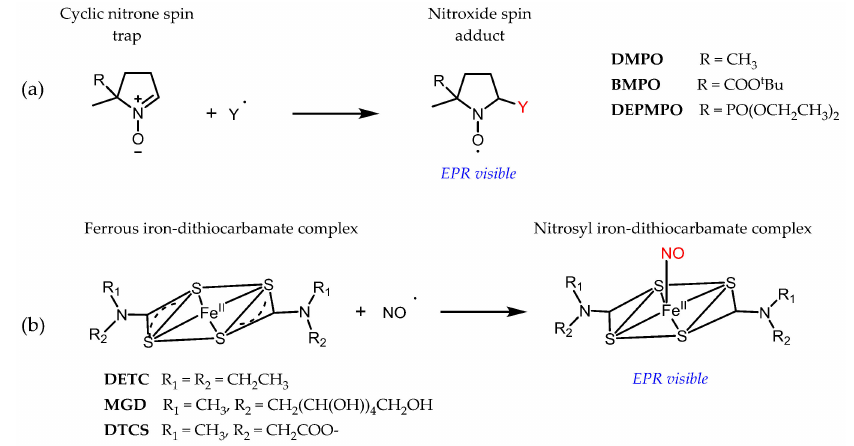
Figure 3. Principle of spin trapping with cyclic nitrone spin traps (a) and ferrous iron-dithiocarbamate complexes (b). In both cases, a covalent bond is formed between the radical and the spin